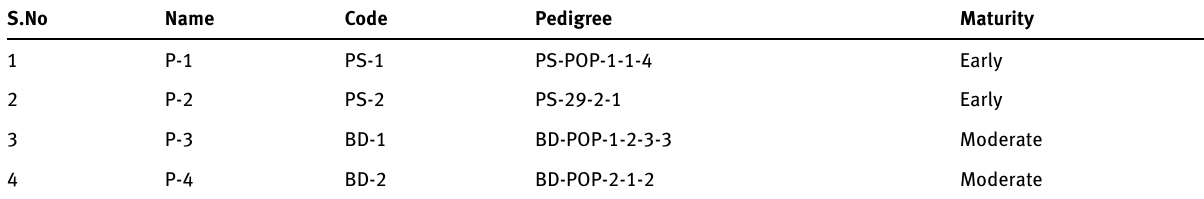
Table 1: Pedigree of the parental inbred lines